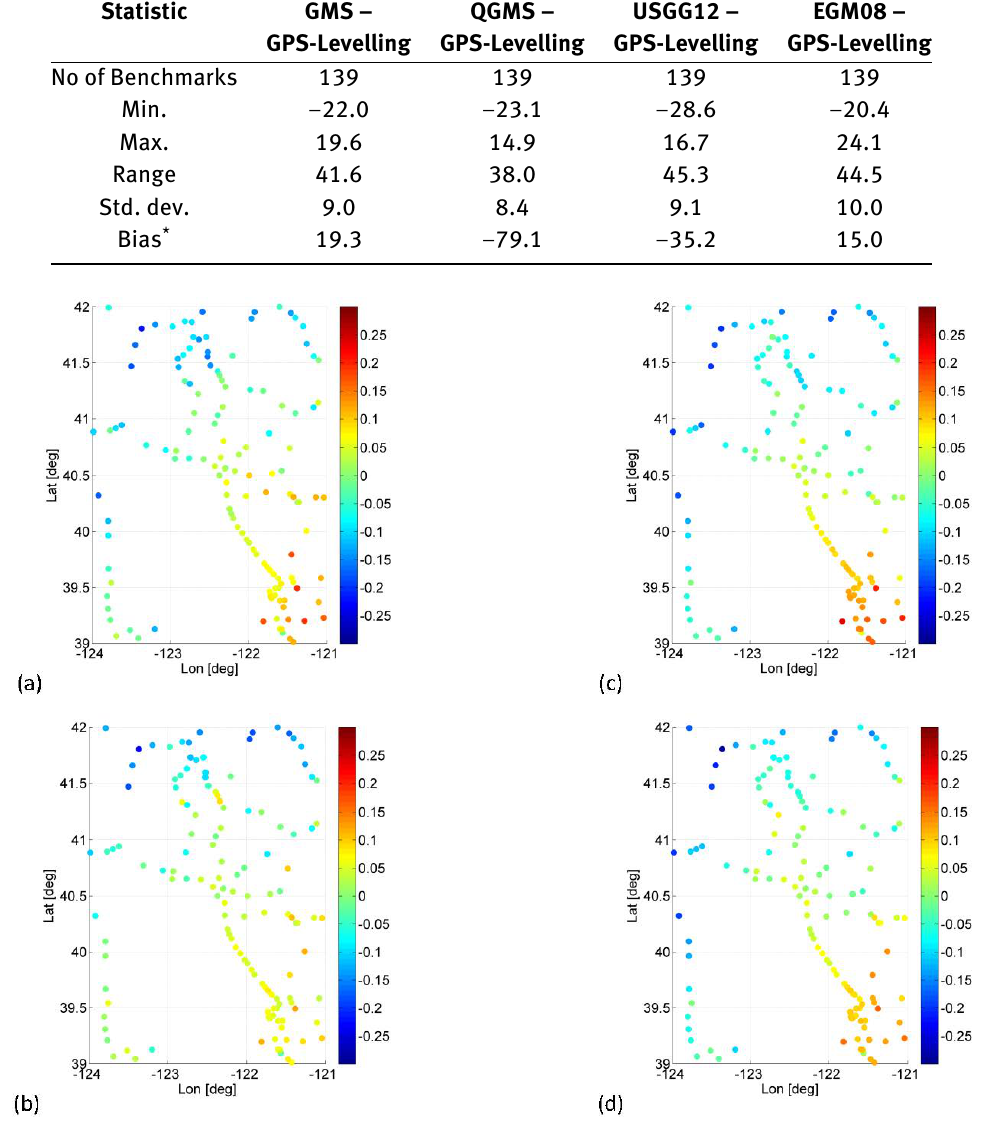
Figure 11: Differences between the different geoids (GMS (a), QGMS (b), EGM08 (c) and USGG12 (d)) and the GPS-Leveling benchmarks for the California test area. The color scale is in